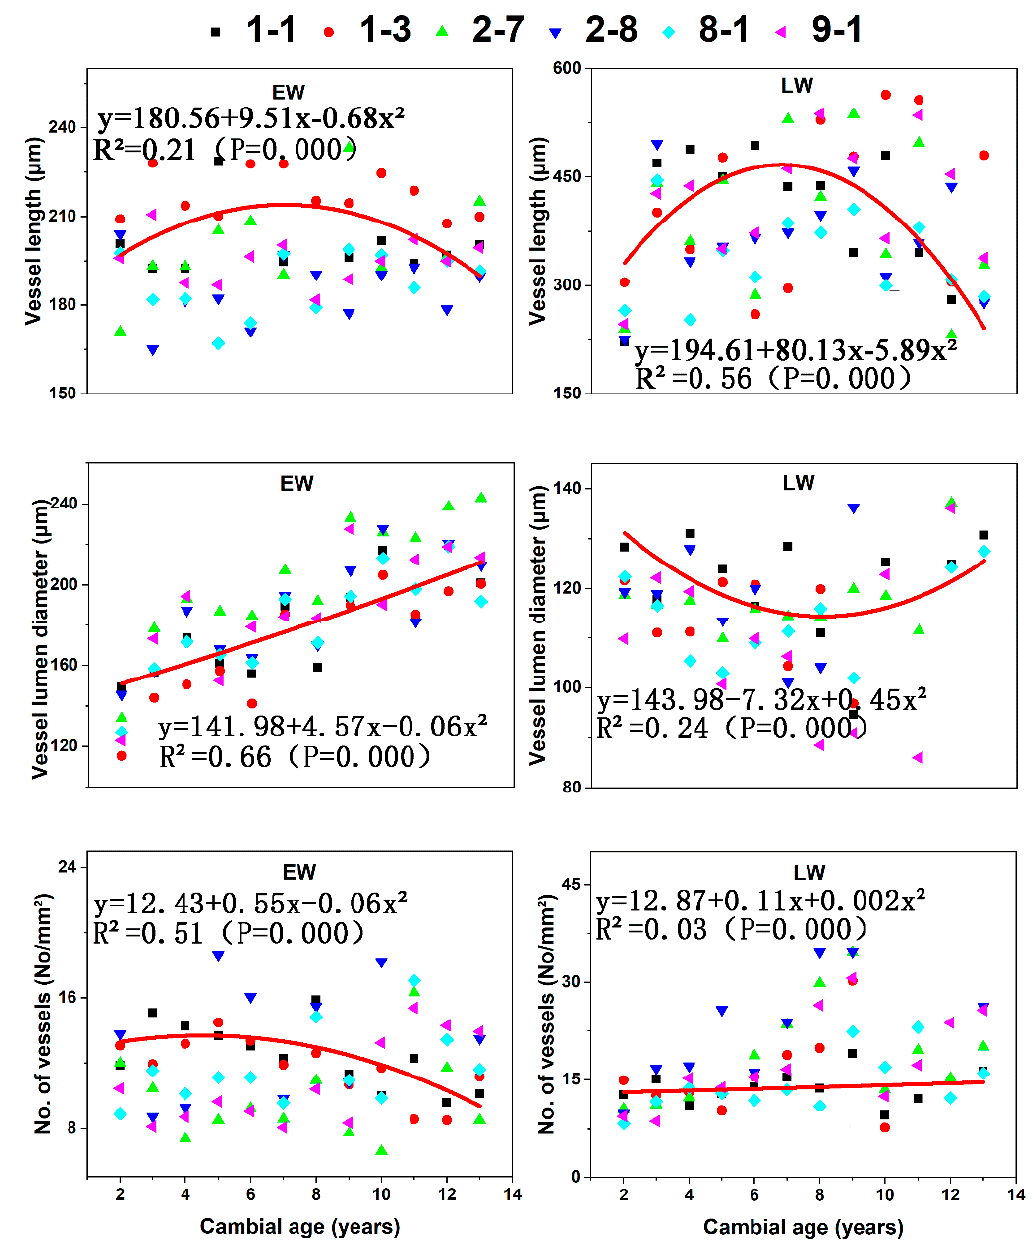
Figure 7. Vessel characters of both earlywood (EW) and latewood (LW): vessel length, vessel diameter, and the number of vessels for the six C. bungei clones versus cambial age. Proportion of fiber in both EW and LW decreased significantly until the eighth year (Figure 8). Proportion of vessel increased with cambial age in EW until the eighth year and then stabilized. Proportion of axial parenchyma in LW also increased until the eighth year and then stabilized similar to the pattern observed for the proportion of vessel. Overall, the proportion of ray, proportion of vessel in LW, and proportion of axial parenchyma in EW did not change